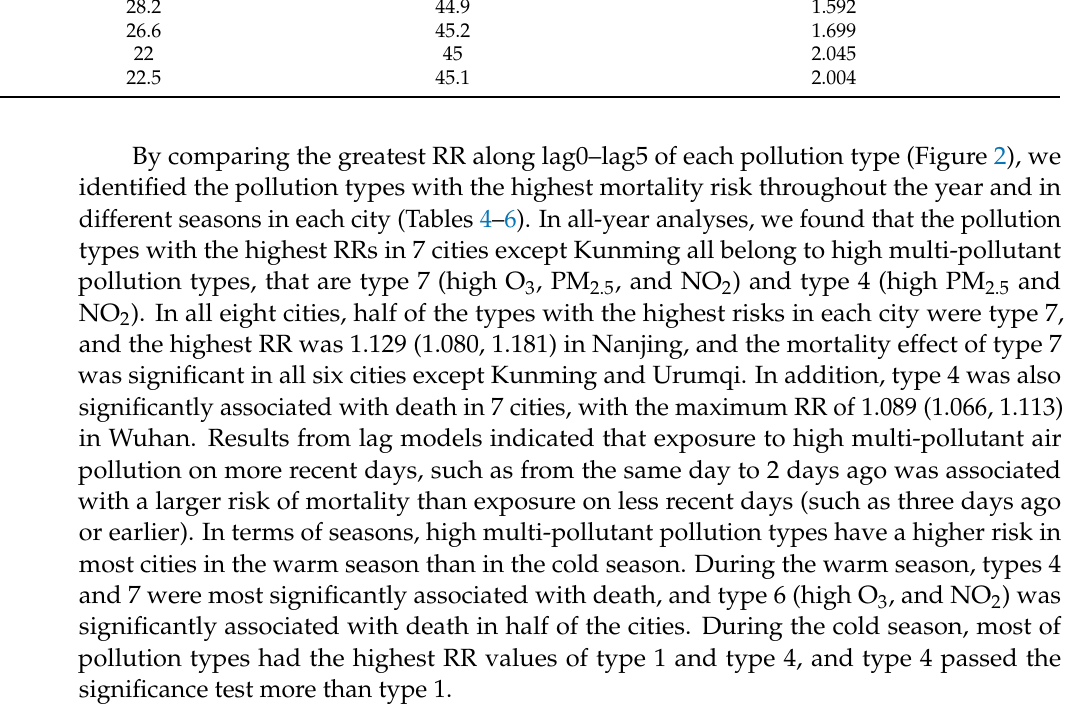
Table 4. The pollution type with the highest lag of 0–5 days and their corresponding risk values and lag days in 8 cities. Pollutants at high levels are listed in parentheses (Annual). ** p < 0.01.